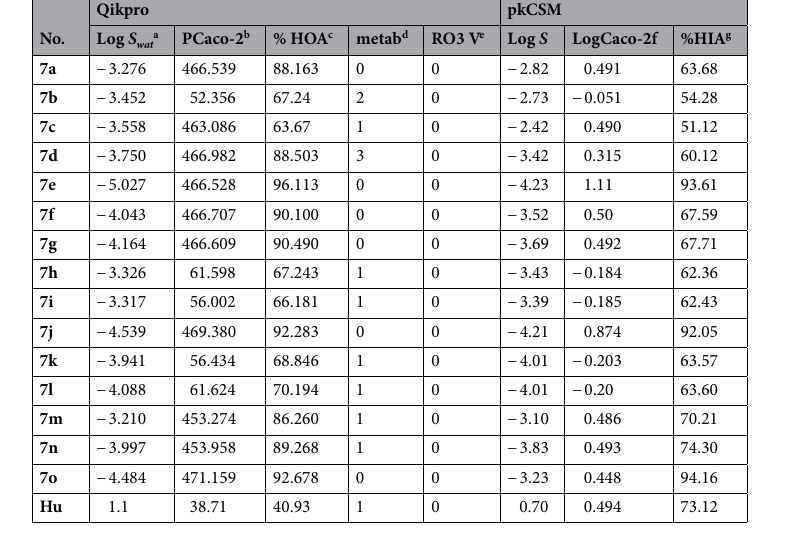
Table 4. The calculated physico-chemical properties of the synthesized compounds 7a–o for predicting absorption procedure. a Predicted aqueous solubility in mol dm −3 (− 6.5 to 0.5) (QPlogS > − 5.7). b Predicted Caco-2 cell permeability in nm/s. c Percentage human oral absorption (< 25% is poor and > 80% is high). d Number of likely metabolic reactions (Primary Metabolites < 7). e Number of violations of Jorgensen’s rule of three. Compounds with fewer (preferably no) violations of these rules are more likely to be orally available. f Predicted Caco-2 cell permeability of a given compound is given as the log Papp in 10 −6 cm/s. g Percent of human intestinal absorption, (< 30% is poor and > 30% is